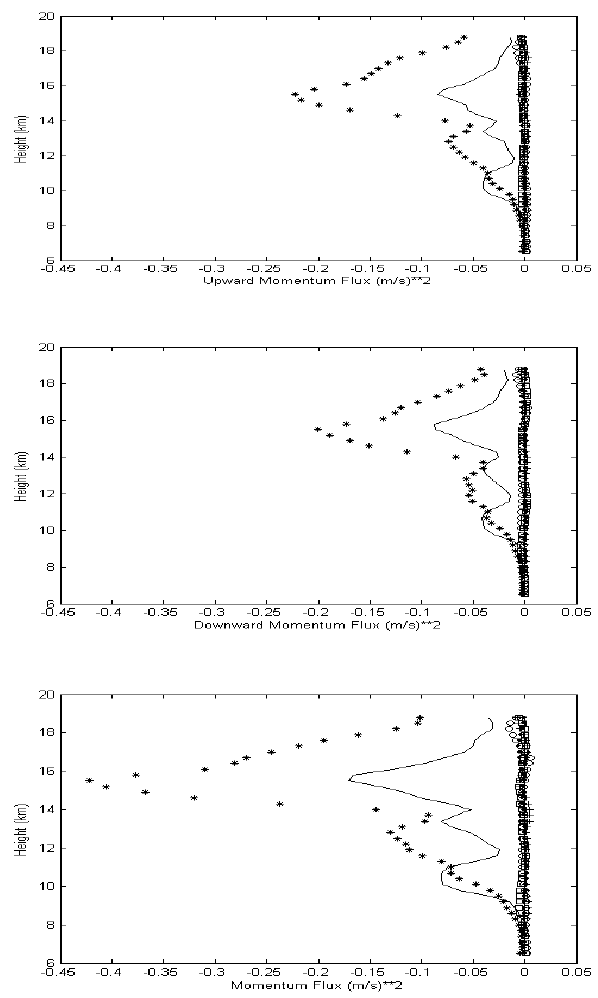
Fig.4 Daily averaged profiles of momentum fluxes in the 10-30 minutes period band. Top Fig. 4. Daily averaged profiles of momentum fluxes in the 10– panel: upward momentum flux ; middle panel: downward momentum flux; bottom panel: 30min period band. Top panel: upward momentum flux; middle total momentum flux. ‘Open circle’ for the 1 st day zonal momentum; ‘line’ for 2 nd day panel: downward momentum flux; bottom panel: total momentum zonal momentum; ‘star’ for 3 rd day zonal momentum; ‘dot’ for 1 st day meridional flux. “Open circle” for the 1st day zonal momentum; “line” for 2nd momentum; ‘cross’ for 2 nd day meridional momentum; ‘open square’ for 3 rd day day zonal momentum; “star” for 3rd day zonal momentum; “dot” for 1st day meridional momentum; “cross” for 2nd day meridional meridional momentum. momentum; “open square” for 3rd day meridional